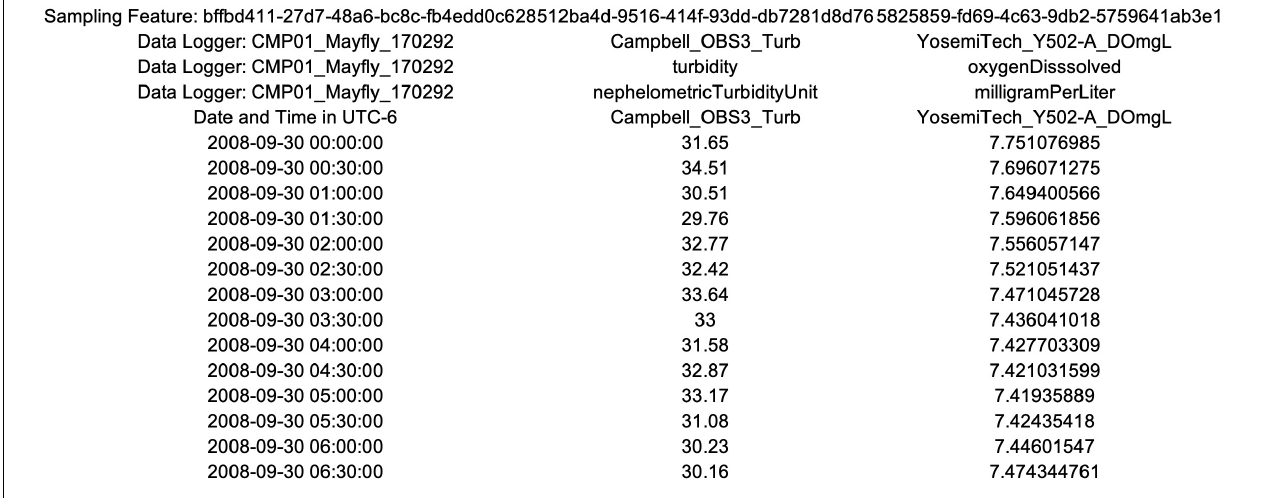
FIGURE 5 | Format of the data upload file showing a brief snippet of data for a site measuring two variables. Files are stored in comma separated value (CSV) format. Comma separators have been omitted from this view of the file for clarity.